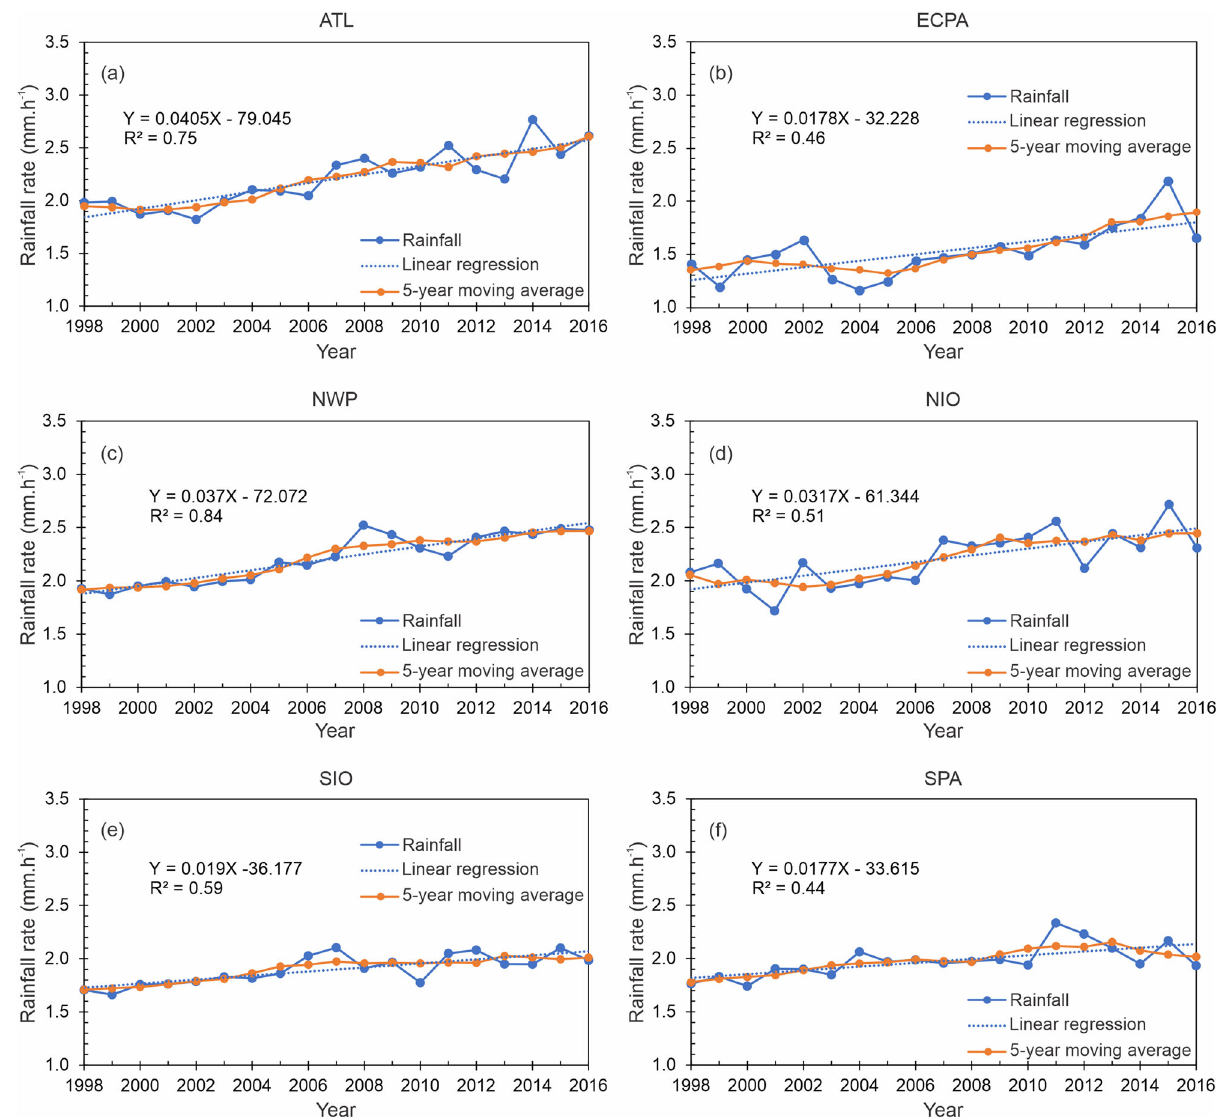
Fig. 2 Time series and the linear regression fi t of TC rain averaged within the total TC rainfall area de fi ned by the tropical cyclone precipitating feature method for TCs in 6 different basins. a Northern Atlantic, b East-Central Paci fi c, c Northwestern Paci fi c, d Northern Indian Ocean, e Southern Indian Ocean, and f southern Paci fi c. The linear fi tting function and square of the correlation are indicated. The 5-year moving average is also